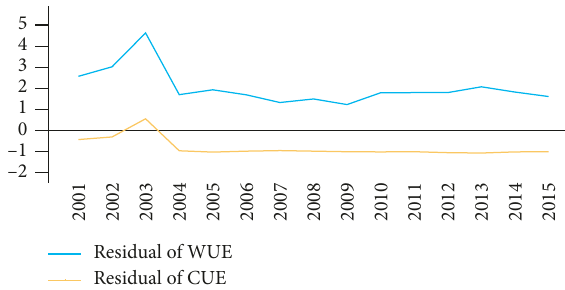
Figure 7: Trends of WUE and CUE residuals in the SNP from 2001 to 2015.